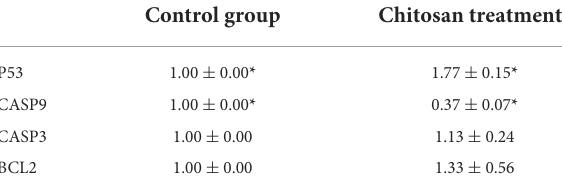
TABLE 1 Chitosan effects on the P53, caspase-3, caspase-9, and BCL_2 mRNA levels in HeLa cells after treatment with chitosan for 24h.